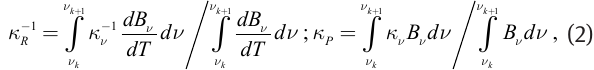
plasma with various 6